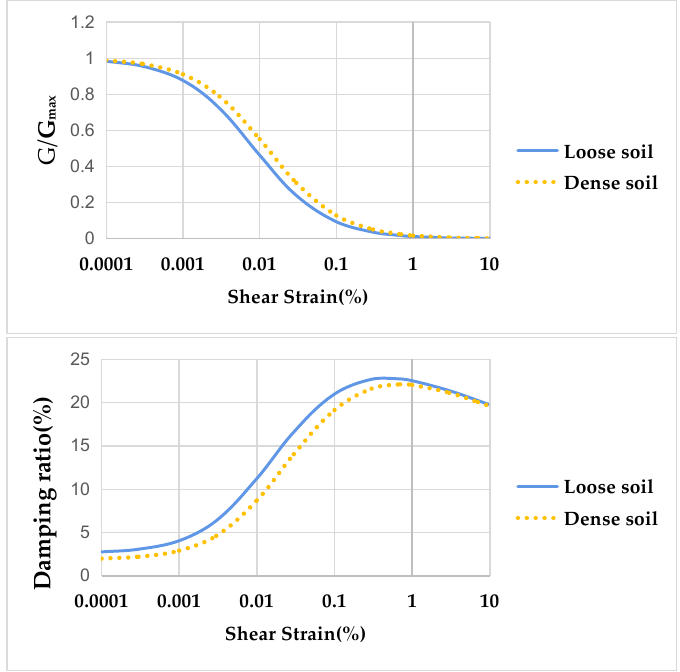
Figure 13. Normalized soil shear modulus and material damping ratio relationship.